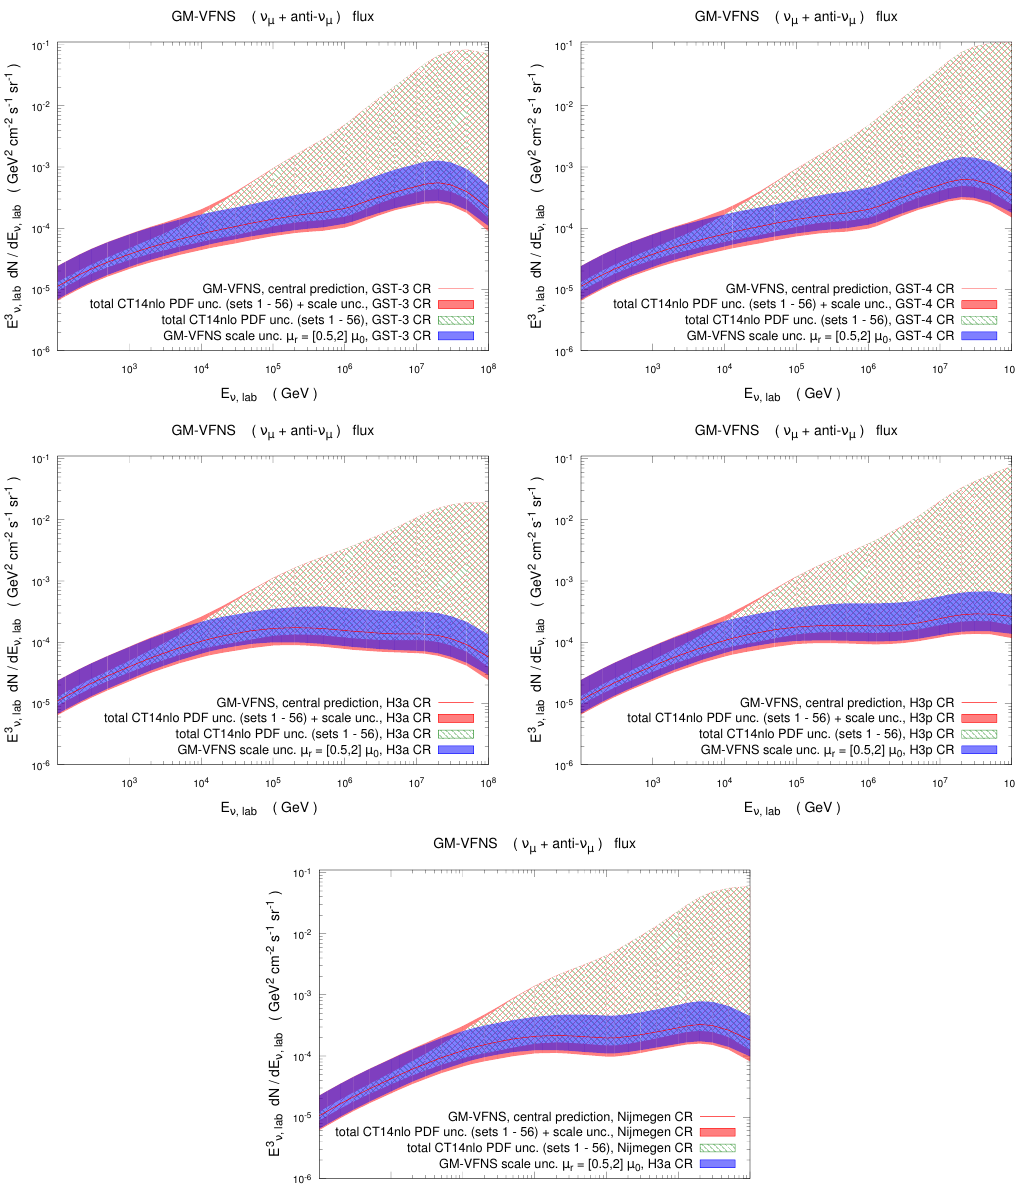
Figure 10 . Prompt-( (cid:23) (cid:22) + (cid:22) (cid:23) (cid:22) ) (cid:13)uxes for di(cid:11)erent CR primary spectra. Scale (blue) and PDF (hatched green) uncertainties, and the result obtained by summing them in quadrature (pink), are shown separately in each panel. Each panel corresponds to a di(cid:11)erent CR primary spectrum (GST-3, GST-4, H3a, H3p and Nijmegen).